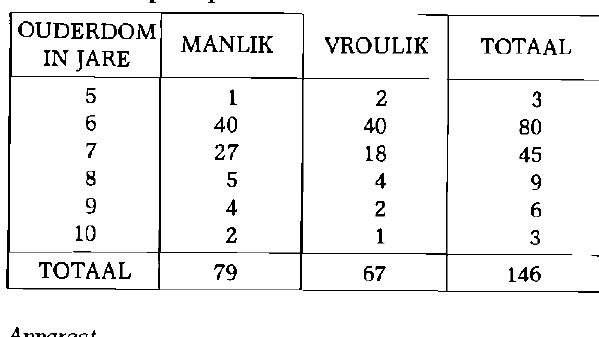
Tabel 1: Voorstelling van relevante gegewens omtrent die proefpersone